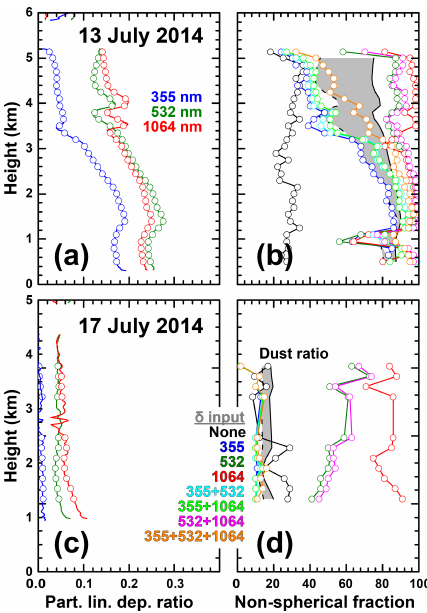
Figure 6. Profiles of (a, c) δ λ and (b, d) the retrieved non- spherical fraction for DISCOVER-AQ Colorado flights on 13 and 17 July 2014. Note that values differ from Fig. 5 in Burton et al. (2015), as we have used a longer averaging period of 23min in our work (see Table